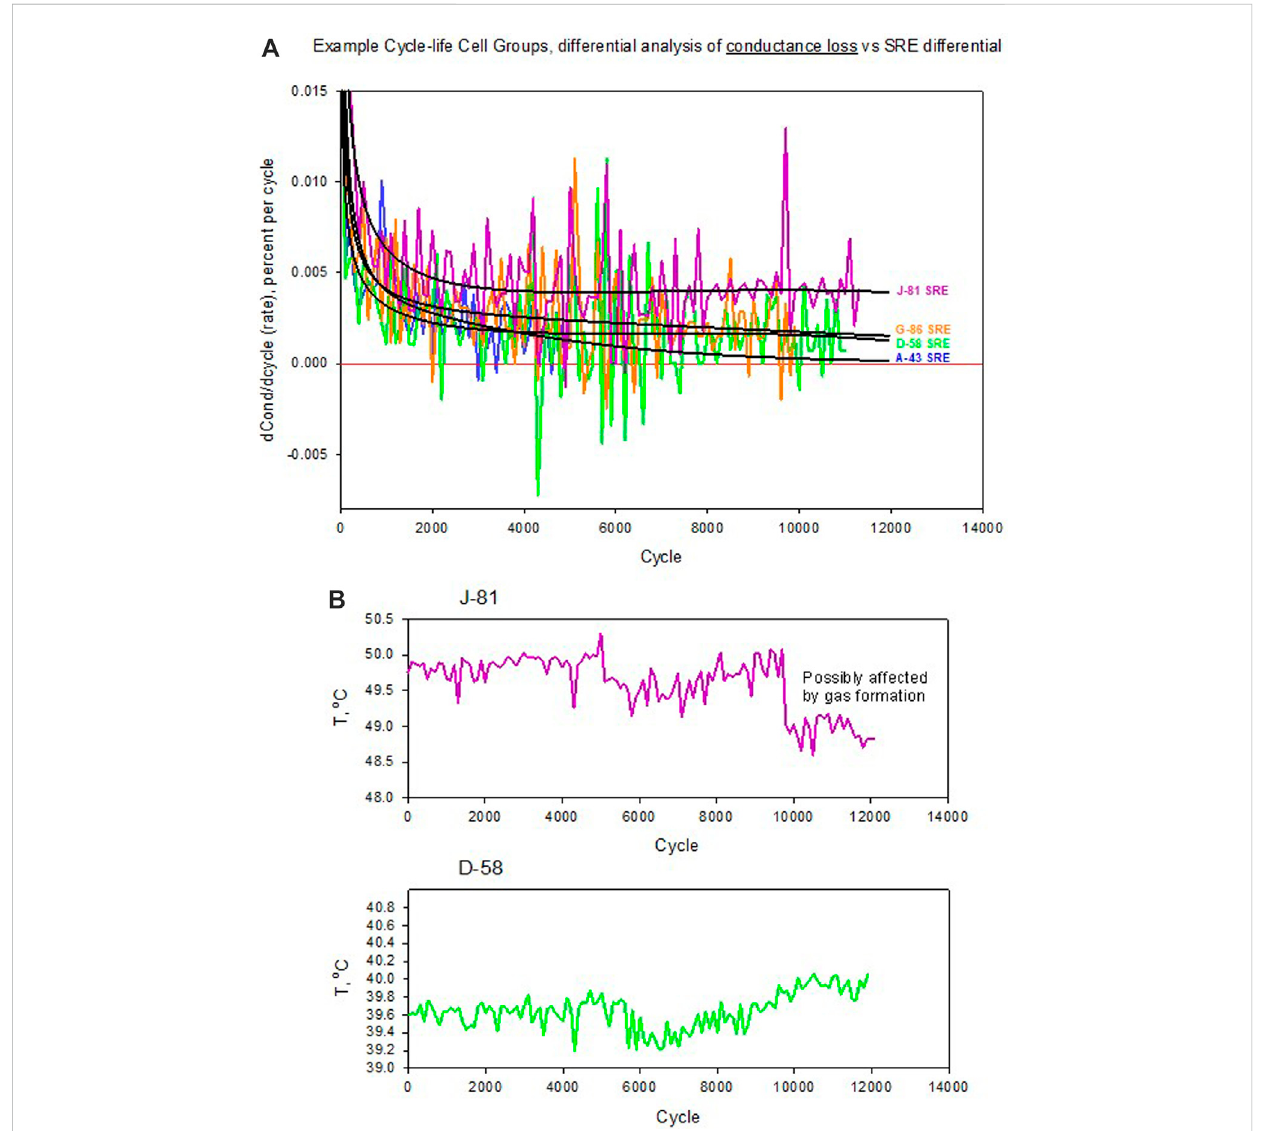
Differential rate analysis of conductance loss for four selected cells from Figure 11, where (A) Differential pro fi les from SRE are overlaid on data for these cells. SRE parameters were obtained from regression of conductance data, typically with R 2 ≥ 0.999. In many instances the magnitude of the data spikes exceed the magnitude of the SRE value, exposing worse cases of measurement variance. Panel (B) shows the accompanying skin temperatures of two of the cells, where the case of cell D-58 demonstrates a correspondence of the rate of conductance loss with temperature rise starting around 6,000